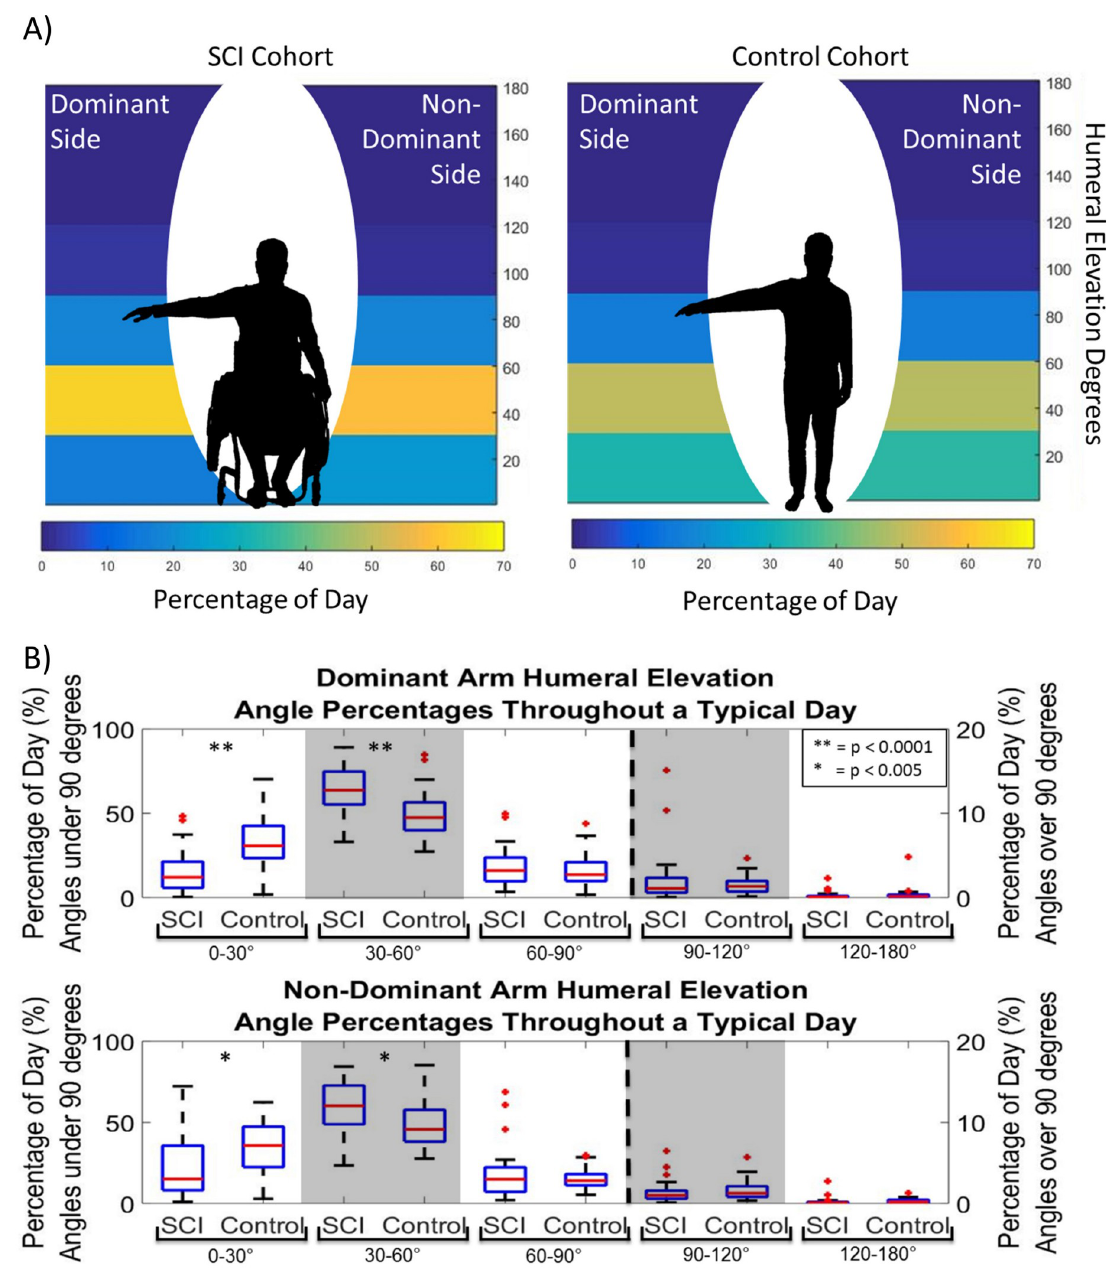
Fig 4. The percentage of time in each humeral elevation. A) The average percentage of time throughout a typical day individuals in the SCI and control cohorts spent in 0–30˚, 30–60˚, 60–90˚, 90–120˚, and 120–180˚ of humeral elevation for their dominant and non- dominant sides. B) Percentage of time throughout a typical day individuals in the SCI and control cohorts spent in 0–30˚, 30–60˚, 60–90˚, 90–120˚, and 120–180˚ of humeral elevation for their dominant arm (top) and their non-dominant arm (bottom). For each boxplot the central line (red) represents the median, the edges of the box are the 25 th and 75 th percentiles, and the error bars extend the most extreme data points not considered outliers and, the outliers are denoted by red +. �� indicates p < 0.0001 and � indicates p <